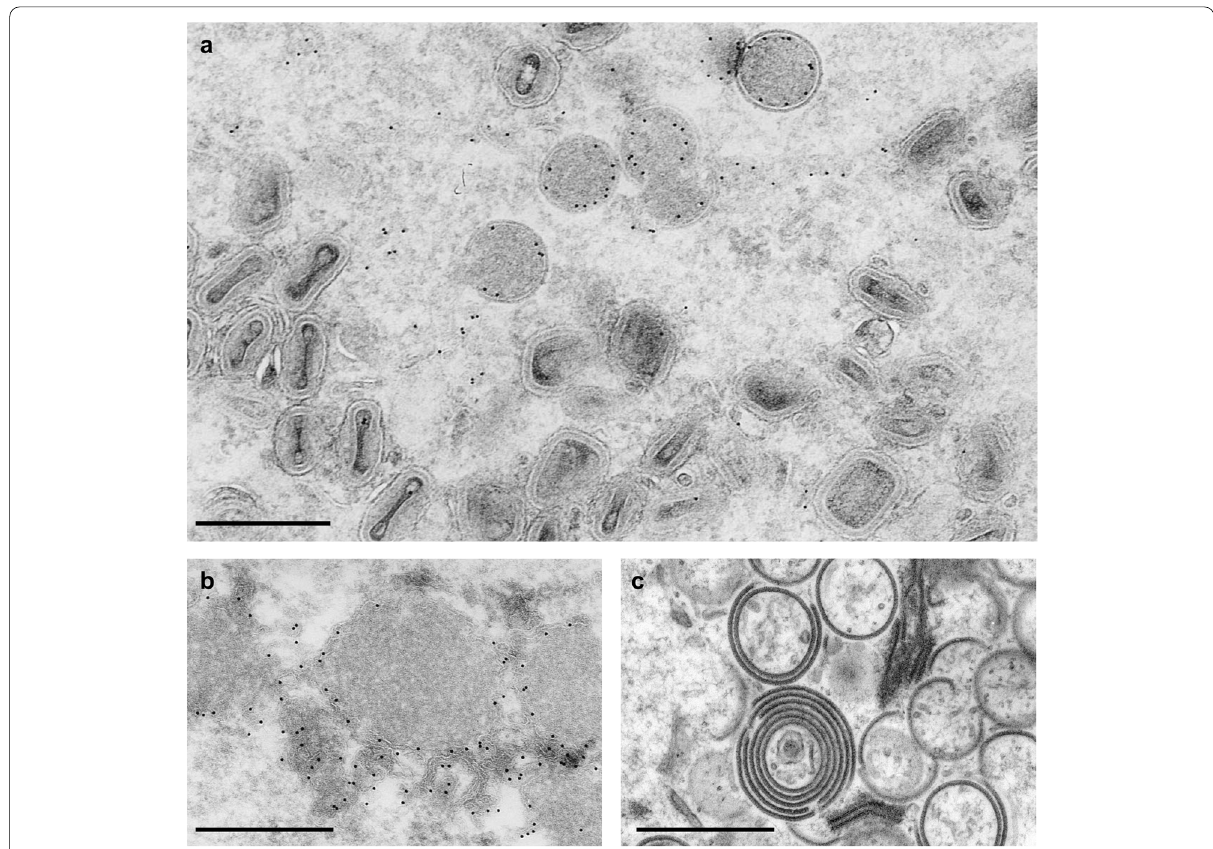
Fig. 2 Correlation between virion morphology and protein components. a Thin-section TEM image showing immature and mature VACV virions inside host cytoplasm in which specific protein (A14) is identified by immuno-gold labeling. b Aberrant virion assembly induced by the addition of assembly inhibitor, rifampicin, showing electron-dense aggregation instead of properly assembled virions. c Aberrant virion assembly in the absence of viral protein A30 in which the protein expression was controlled by IPTG induction. Scale bars are 0.5 μm. The images are reprinted